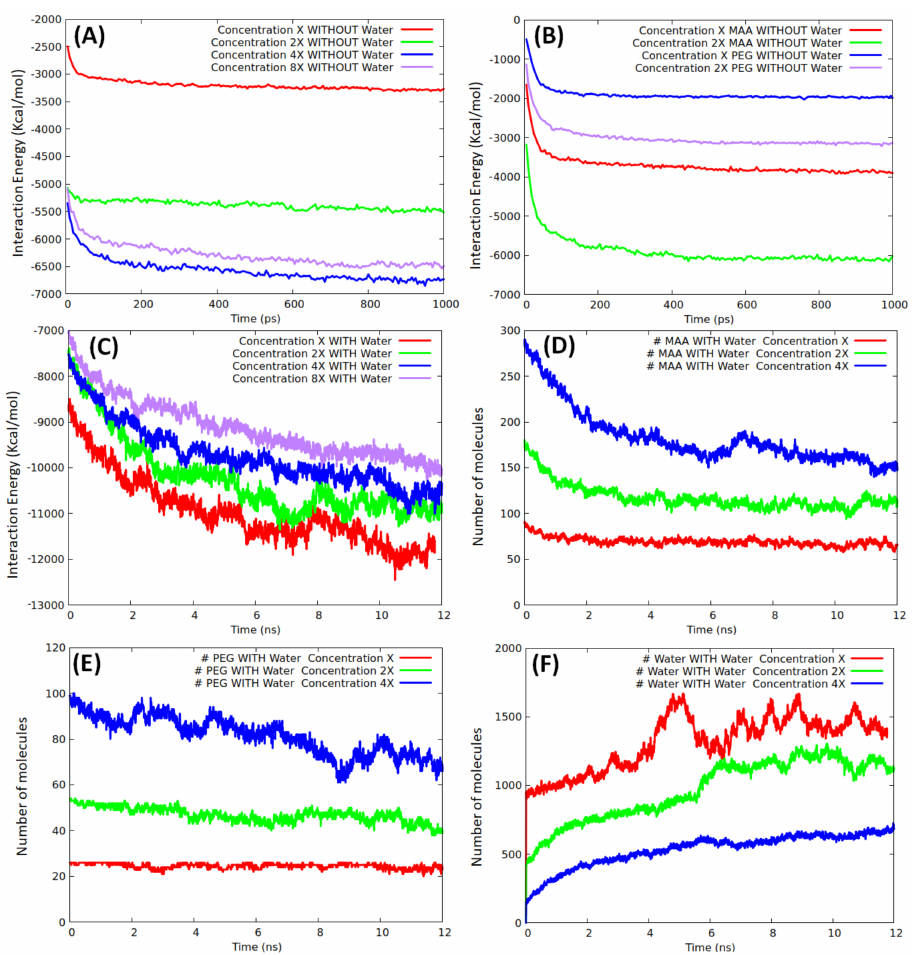
Figure 3. Interaction energy between the protein and the monomers (kcal/mol) as a function of simulation time: ( A ) total, without water; ( B ) MAA and PEG, without water; ( C ) total with water. Evolution of the number of the adsorbed molecules in water within 3.5 Å from the protein surface: ( D ) MAA, ( E ) PEG, and ( F )